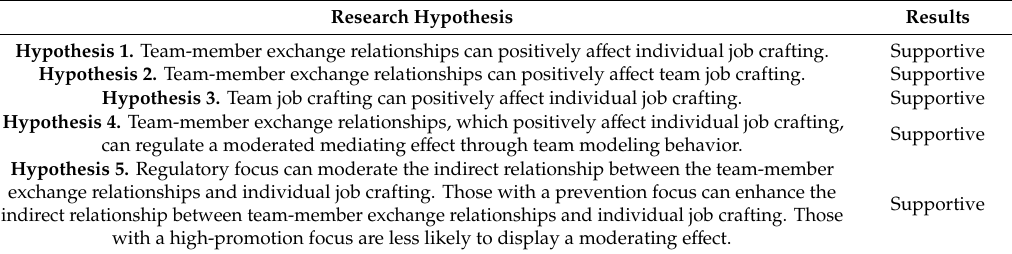
Table 13. Summarization of